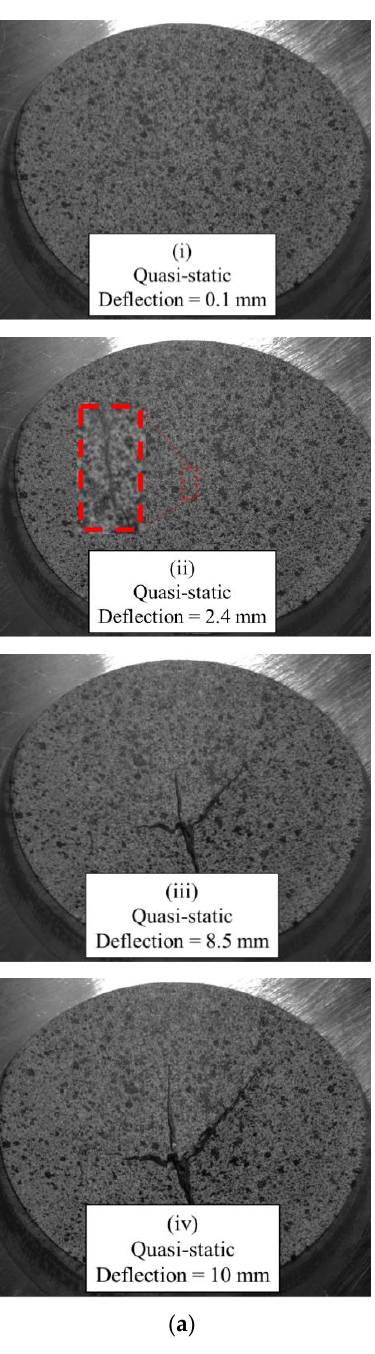
Figure 19. Images of specimen face opposite indenter: ( a ) quasi-static, ( b ) low-velocity impact.